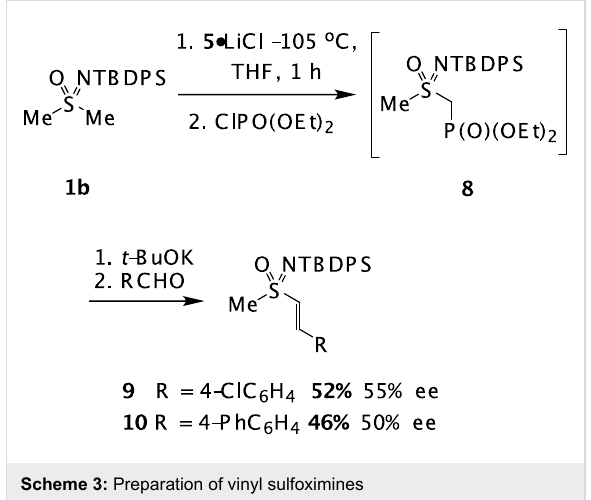
Scheme 3: Preparation of vinyl sulfoximines